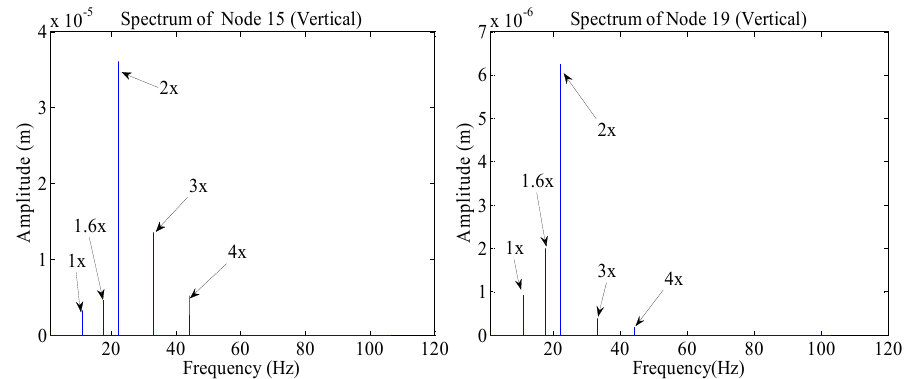
Figure 16. The spectrum of Bearing 3 and Bearing 4 (equal weight coefficients).